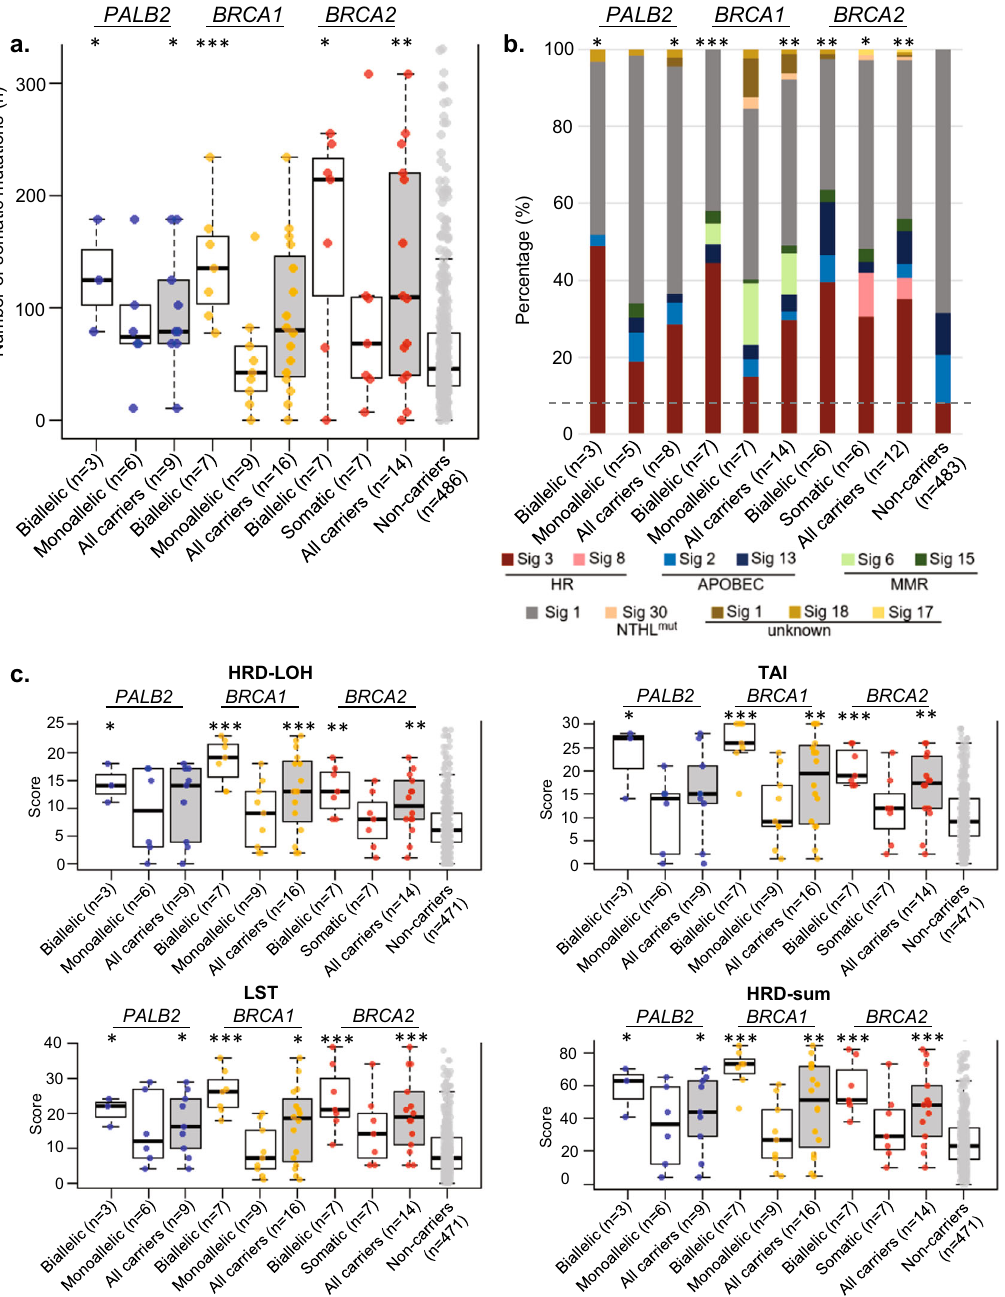
Fig. 4 Comparison of mutational pro fi les of tumours (with integrated germline and somatic alterations) that arise from mutation carriers of PALB2, BRCA1 and BRCA2 and non-carriers, strati fi ed by allelic status of tumours. a Total number of somatic alterations (single nucleotide variants (SNVs)) and indels identi fi ed in tumours with PTVs. b The stacked bar plot shows the proportion of major mutational signature in aggregate for each category. The horizontal grey dashed line indicates the proportion of mutational signature 3 in tumours that arise from non-carriers as reference for comparison. Only samples with at least 15 SNVs were included in this analysis. c Comparison of genomic scar scores for tumours with PTVs and tumours without any alterations (non-carrier group). All samples were included in this analysis except those with no Sequenza fi les due to unavailability of either WES germline or tumour data. Boxplots represent medians (centre line) and interquartile range, and whiskers represent the maximum and minimum values within 1.5 times the interquartile range from the edge of the box. Each data point represents an individual sample. P values: Comparison of each category vs non-carrier. *** p < 0.001; ** p < 0.01; * p < 0.05; Mann – Whitney U test ( a , c ); Chi-square test ( b